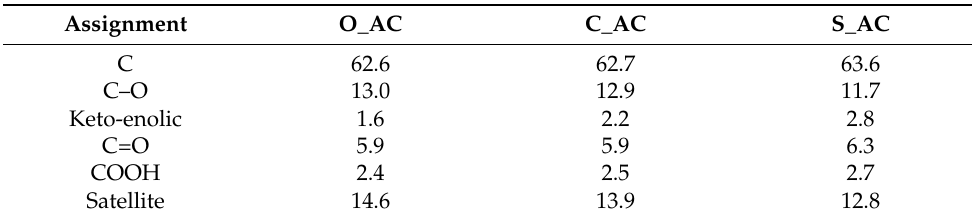
Table 3. The content of C 1 s components expressed as atomic concentrations.